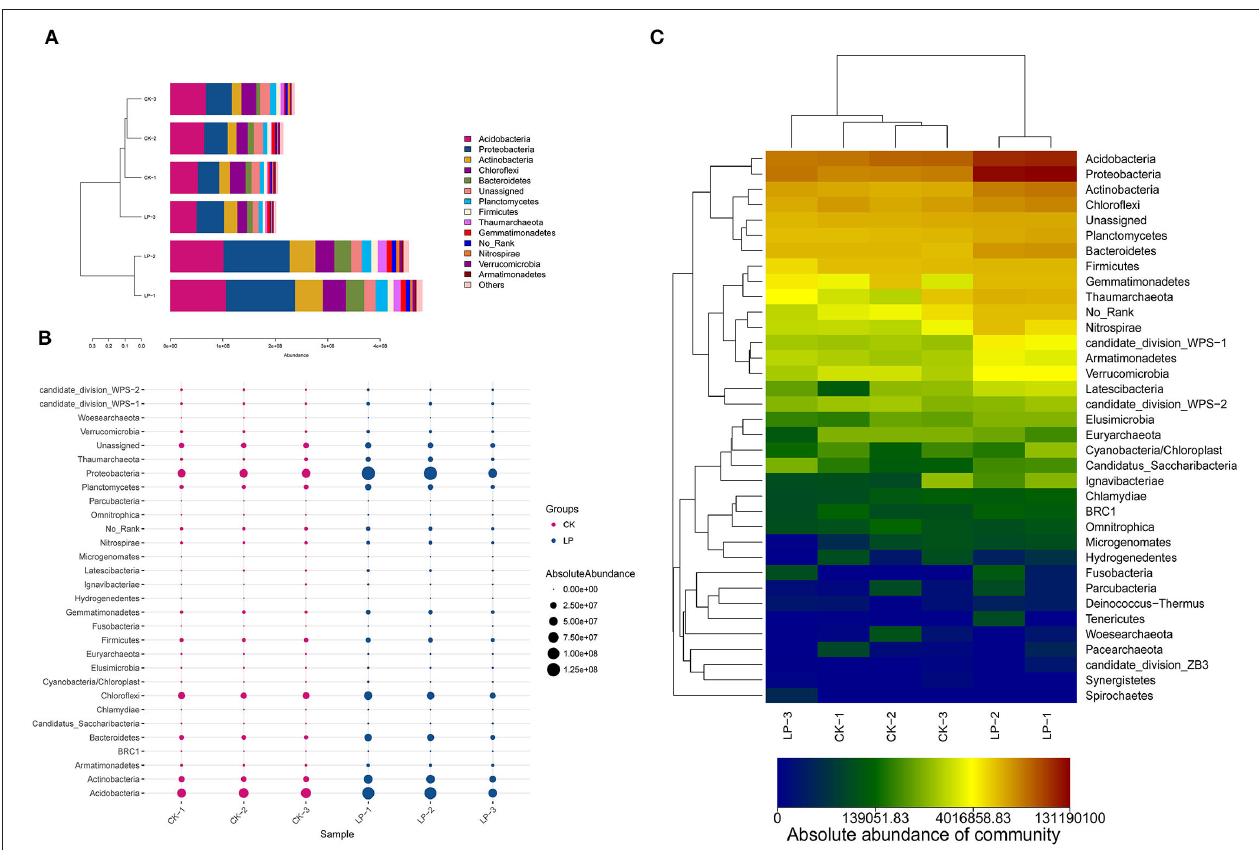
FIGURE 4 | Compositional analysis of bacterial community at the phylum level. (A) Bar plot of the compositional alteration of the soil bacteria in the intercropping group (the proportion > 1%). (B) The bubble chart with changes of absolute abundance ( > 1%) in soil bacteria between LP and CK groups. (C) Heat map of soil different bacterial composition at the phylum